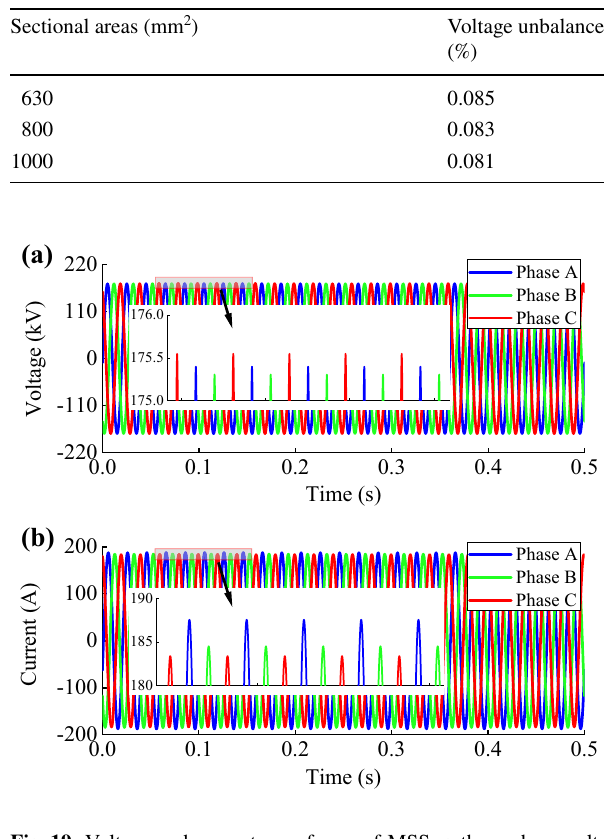
Fig. 19 Voltage and current waveforms of MSS: a three-phase volt- age; b three-phase